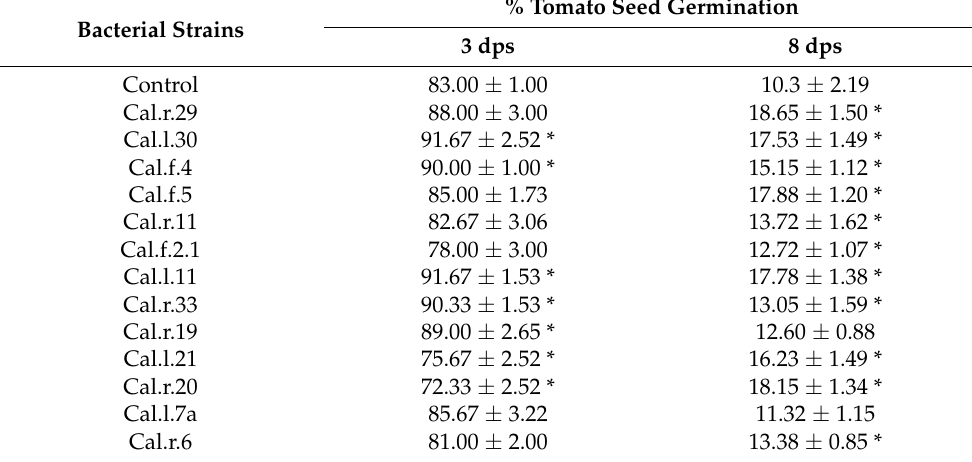
Table 2. Tomato seed germination after bacterial seed bio-priming. The values represent the average of the measurements and the standard deviations of the values. The asterisks indicate statistically significant differences ( p < 0.05) between the values (n = 50) compared to the control plants per observation days after Dunnett’s